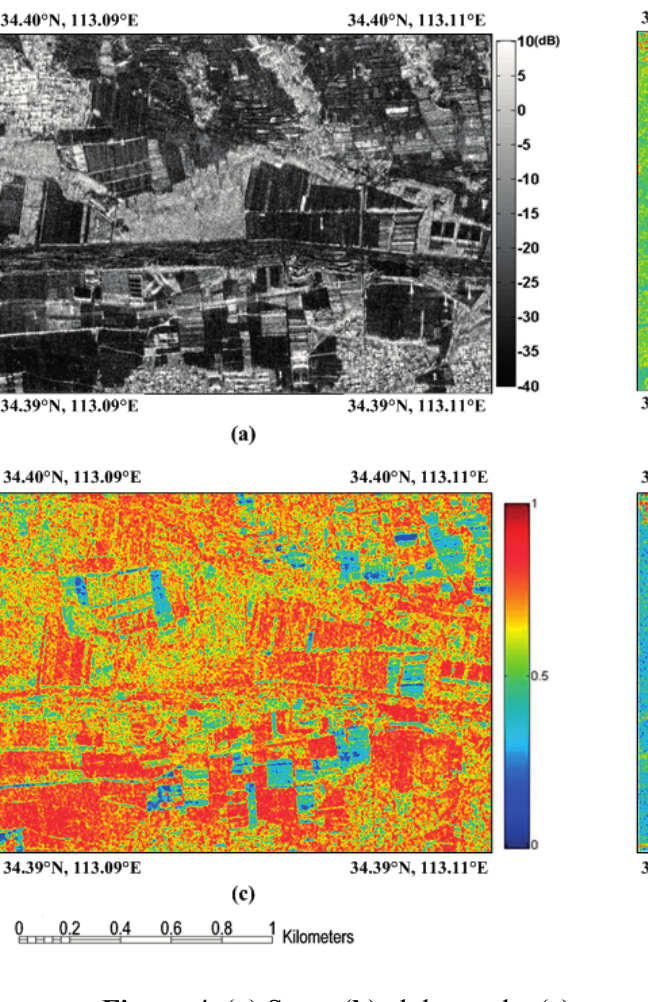
Figure 4. ( a ) Span, ( b ) alpha angle, ( c ) entropy, and ( d ) anisotropy of the study